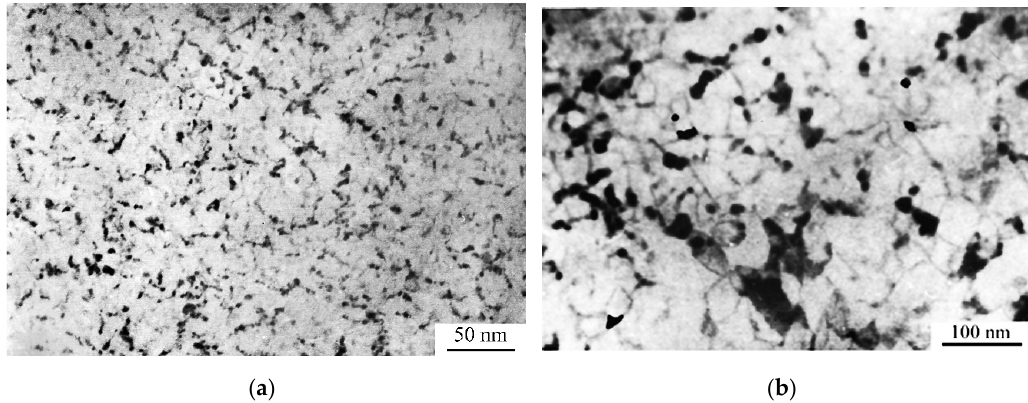
Figure 10. Microstructure of Fe 84 B 16 alloy sample annealed in an electron microscope (in-situ) at 623 K for 90 min: ( a ) bright-field and ( b ) dark-field images [reproduced from Mat. Sci. [73]. Eng., 1978, 36, 193 with permission from Elsevier, 2020].